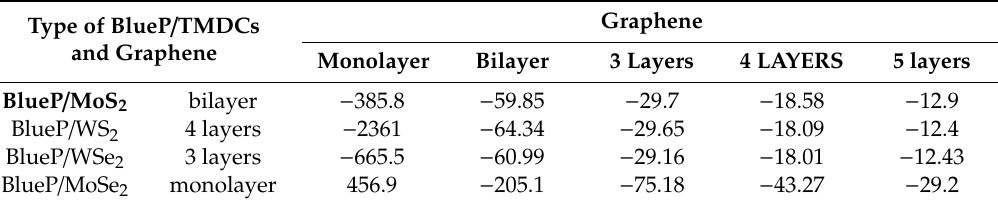
Table 5. The optimal GH shift (S / λ ) with di ff erent number of BlueP / TMDCs and graphene layers. Type of BlueP / TMDCs